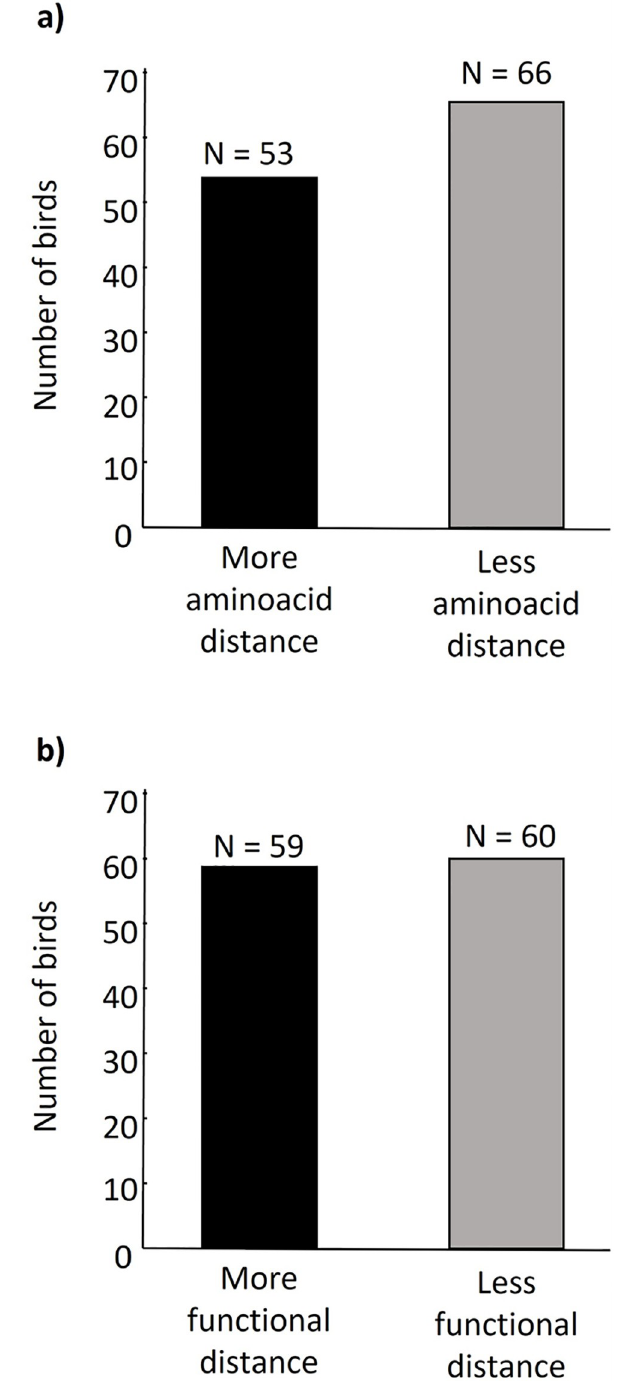
Fig 3. Number of birds that chose the side of the olfactometry chamber containing the scent of a conspecific of the opposite sex with greater (black) or lower (grey) a) MHC-I amino acid distance or b) MHC-I functional distance.